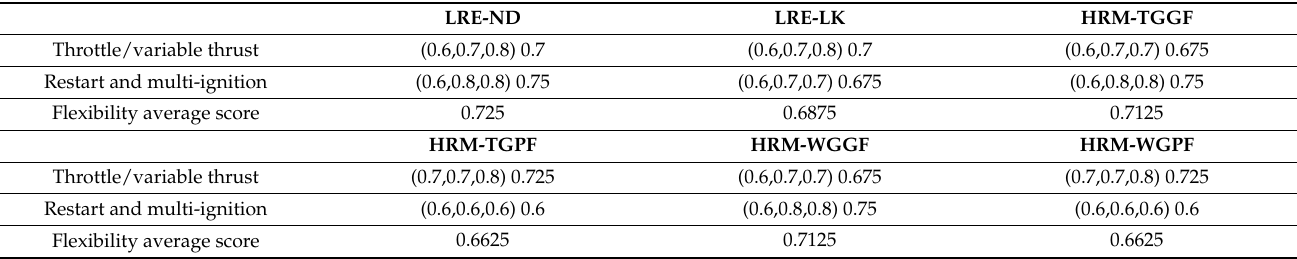
Table 4. Flexibility results of expert